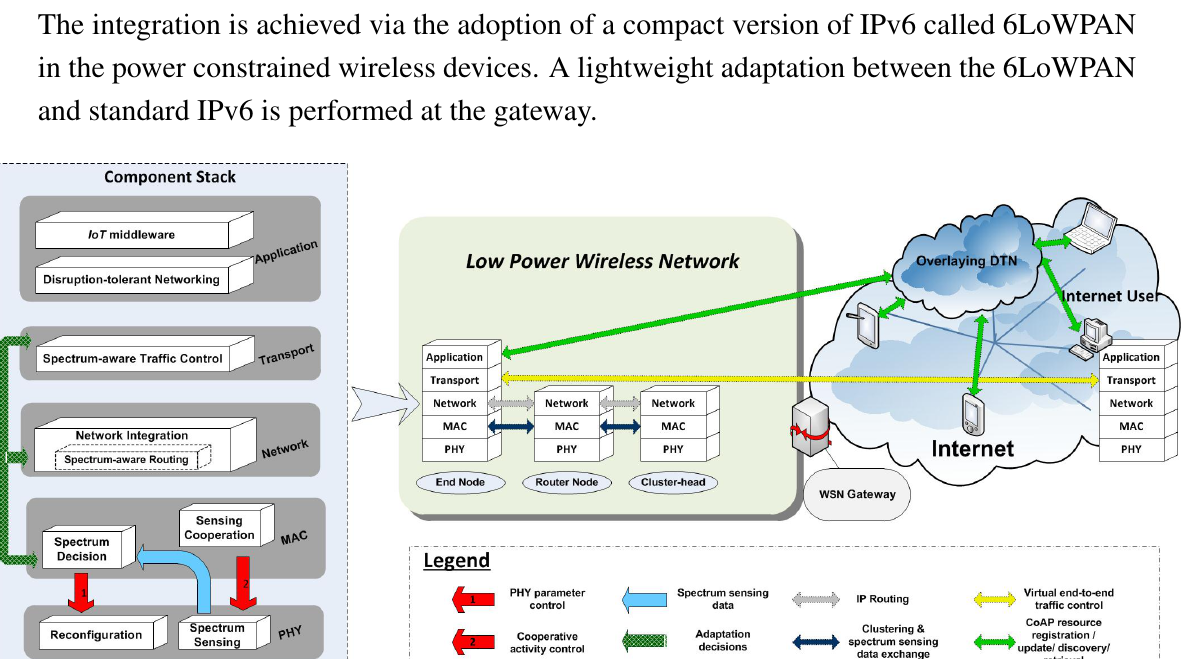
Figure 1. Adaptation Opportunities and Techniques: The Component Stack to the left highlights the adaptive opportunities identified at different layers of a typical low-power IoT product such as wireless sensors. The rest of the figure demonstrates an exemplar scenario of interactions between traditional Internet hosts and adaptive wireless